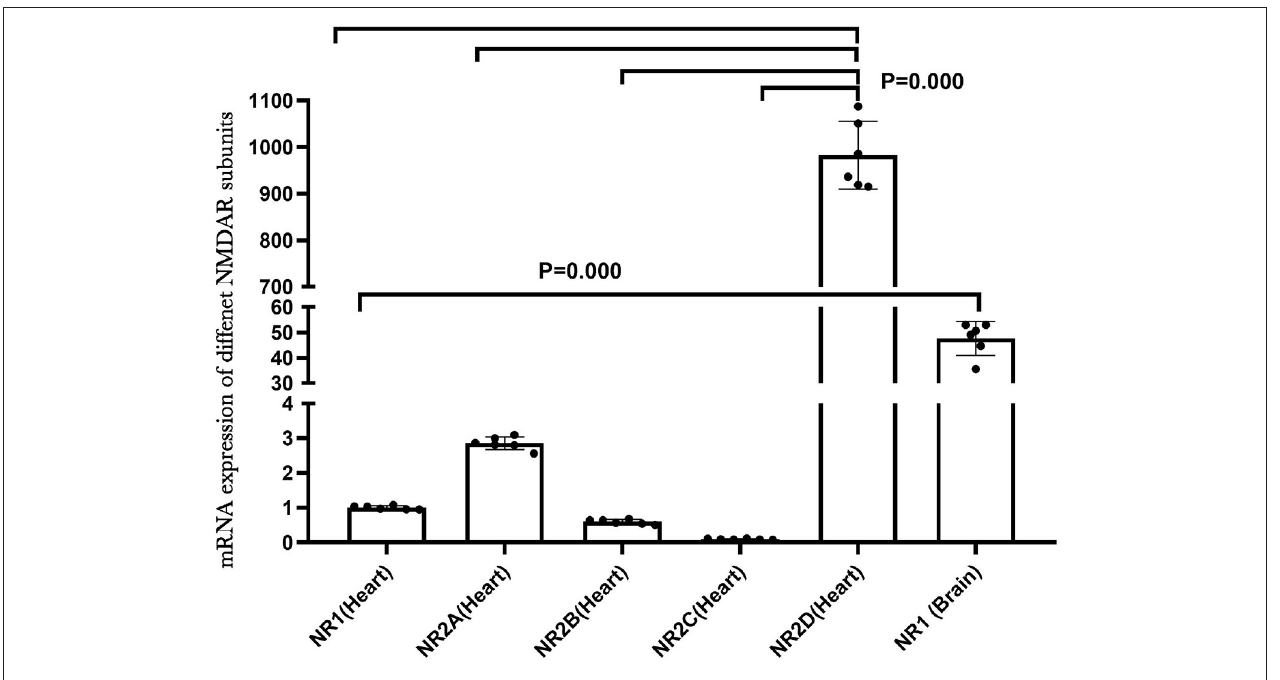
FIGURE 1 | NMDA receptor subunits expression in the neonatal rat heart.